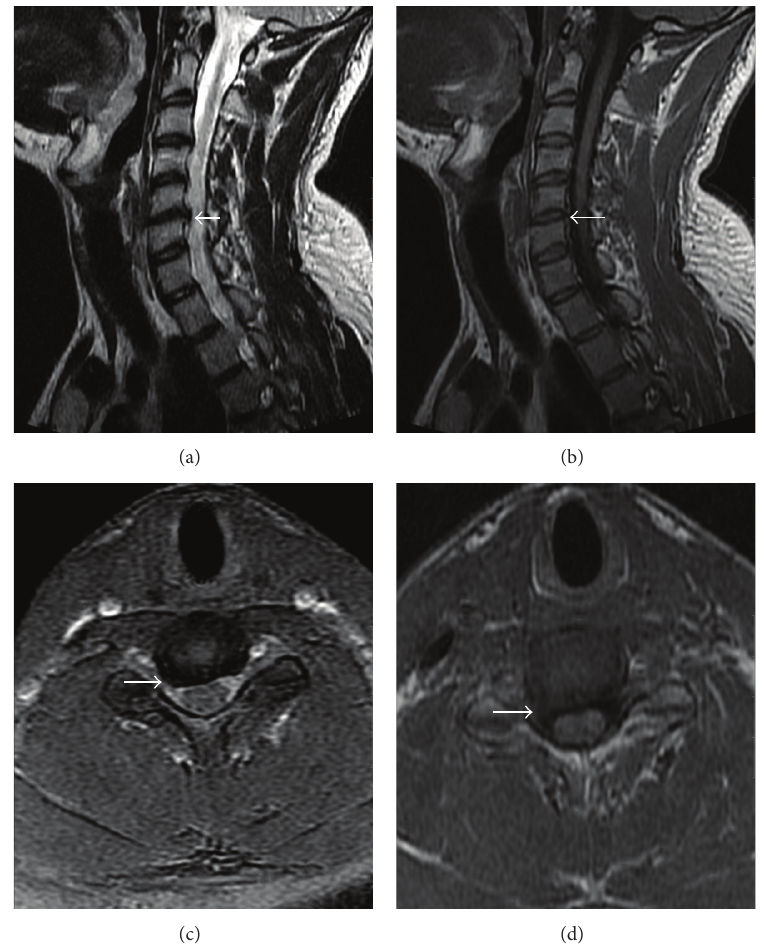
Figure 2: Sagittal T2-weighted (a), sagittal T1-weighted (b), axial T2 ∗ (c), and axial T2-weighted (d) MRI images show regression of the large disc extrusion at C5-C6 level. Only a small disc protrusion and marginal vertebral osteophytes are now seen at this level